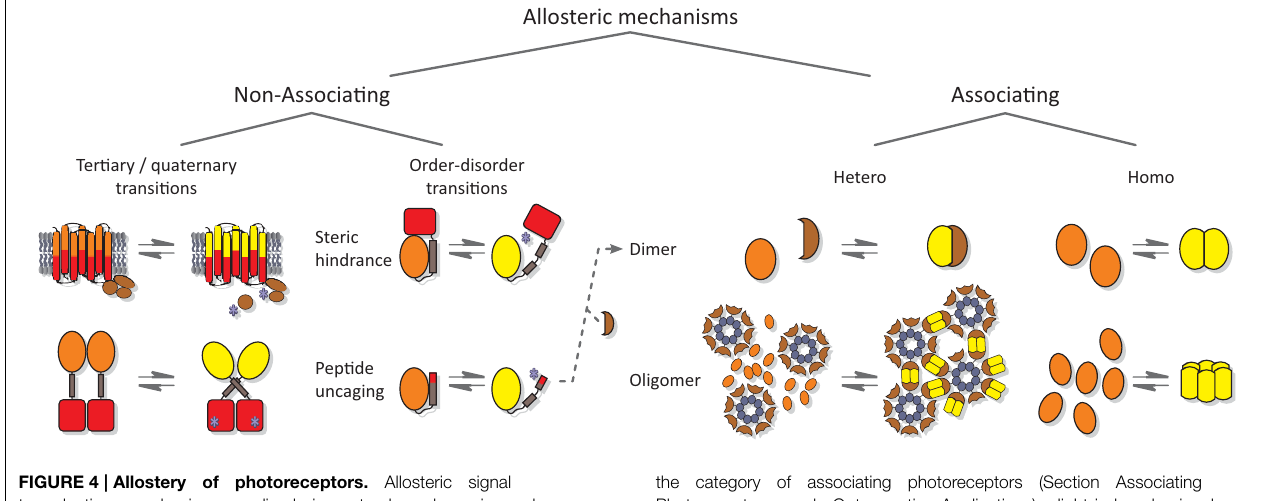
FIGURE 4 | Allostery of photoreceptors. Allosteric signal transduction mechanisms realized in natural and engineered photoreceptors are grouped into non-associating and associating categories. Within the category of non-associating photoreceptors (Section Non-associating Photoreceptors and Optogenetic Applications), a disparate subclass of receptors relies on light-induced transitions of tertiary and quaternary (other than association) structure to regulate biological activity (Section Light-regulated Tertiary and Quaternary Structural Transitions). A second subclass capitalizes on light-induced order-disorder transitions, epitomized by J α helix unfolding in As LOV2 (Harper et al., 2003), most often to restrict access to either an effector active site or to a peptide epitope in light-regulated manner (Section Light-regulated Order-disorder Transitions). Within